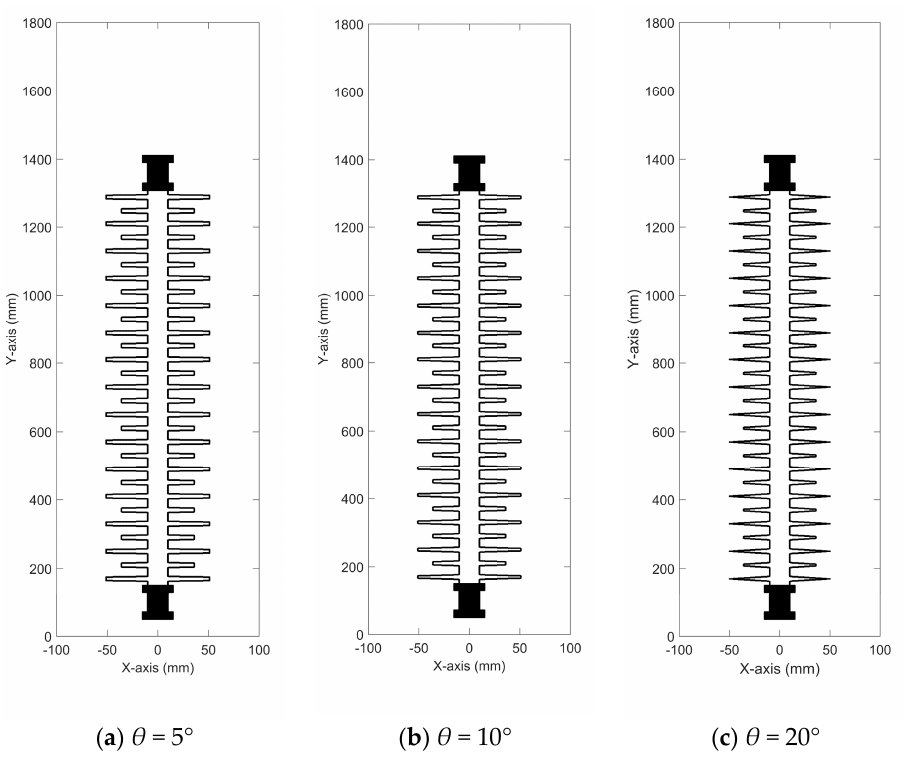
Figure 15. Insulator geometry with different shed angles ( CF = 3.0 and k shed = 0.8).